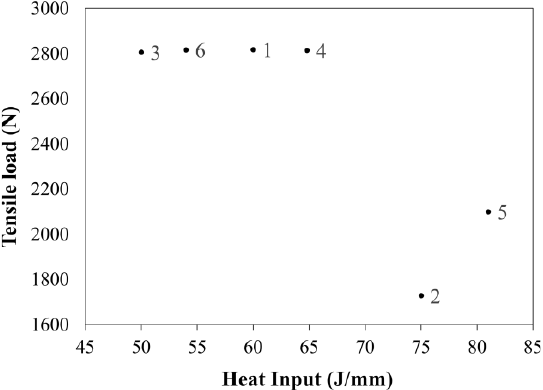
Figure 8. Maximum tensile load of the welded joints versus heat input. The numbers in the graph refer to the experimental run.